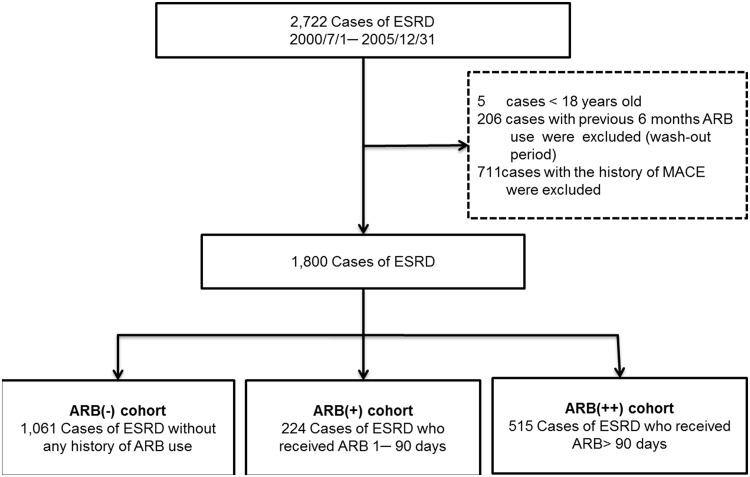
Flowchart of selecting study subjects.